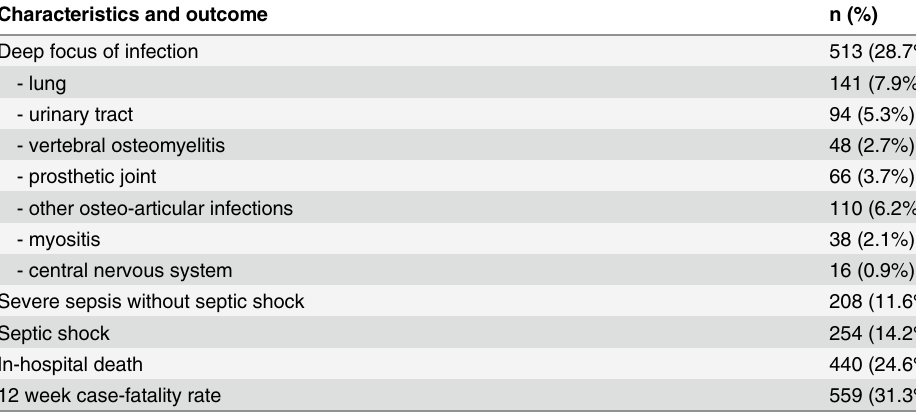
Table 3. Complication and outcome of the 1787 Staphylococcus aureus bloodstream infections with- out infective endocarditis, VIRSTA Study 2009 – 2011.